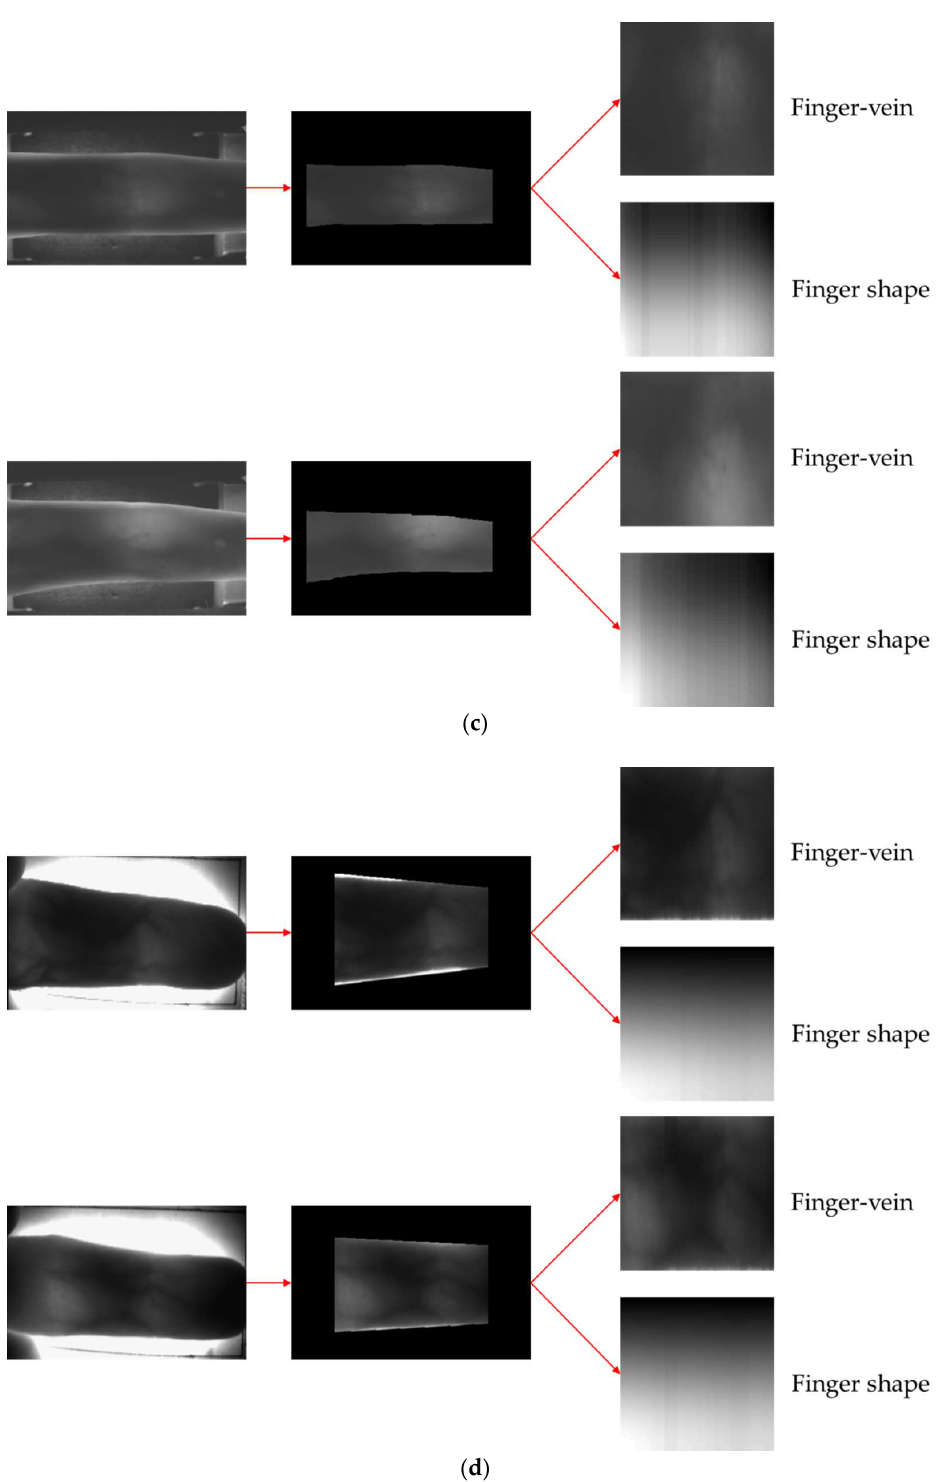
Figure 13. Examples of the correct recognition cases. ( a , b ) the correct acceptance cases with SDU-DB and PolyU-DB, respectively. ( c , d ) the correct rejection cases with SDU-DB and PolyU-DB, respectively. In ( a – d ), upper and lower images show the enrolled and input images, respectively. In ( a – d ), left and middle images present the input and corresponding finger ROI. The right-upper images show that for obtaining the difference image for finger-vein recognition, whereas the right-lower images present the spectrogram images for finger shape recognition .